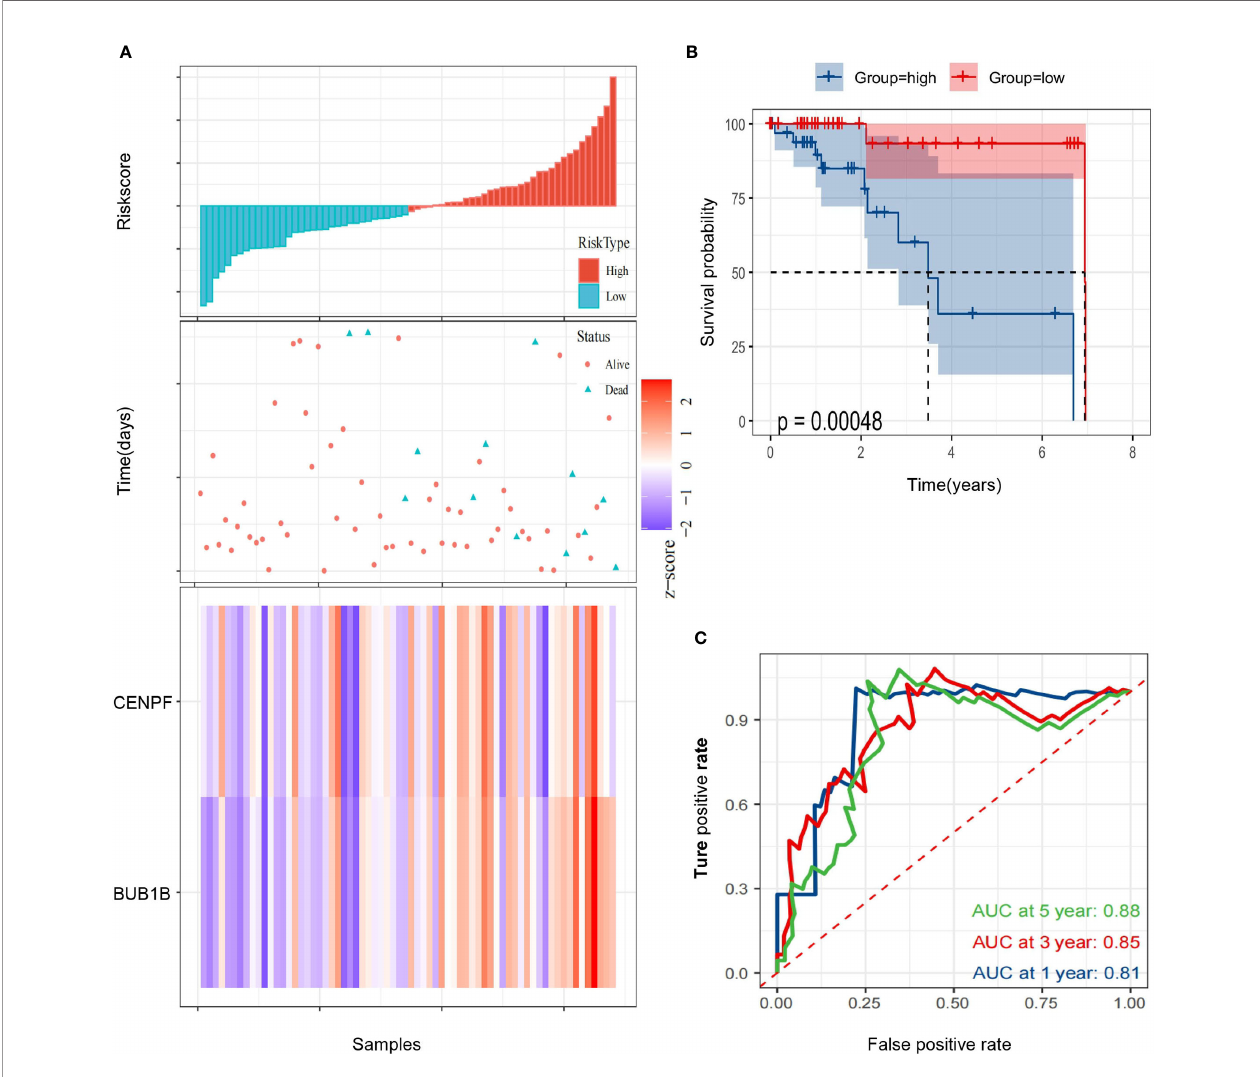
FIGURE 5 | Identi fi cation of a 2-gene signature model associated with the overall survival of patients with alcohol-related HCC. (A) The risk scores distribution, survival status, and gene expression patterns of patients in high and low risk groups. (B) The Kaplan-Meier curve analysis of overall survival of alcohol-related HCC patients between high and low risk groups. (C) The time-dependent ROC curves